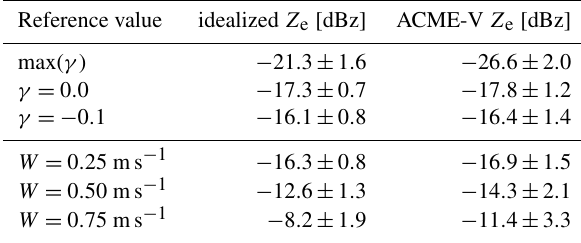
Figure 3. (a) Reflectivity Z e skewness γ and (b) reflectivity Z e mean Doppler velocity W relationships for the individual model runs using synthetic initial model conditions. The black lines denote the medians as a function of Z e ; the error bars are estimated using bootstrapping for selected γ and W values (see Table 2). Color is for model run time. Table 2. Mean Z e values at various reference points for γ and W